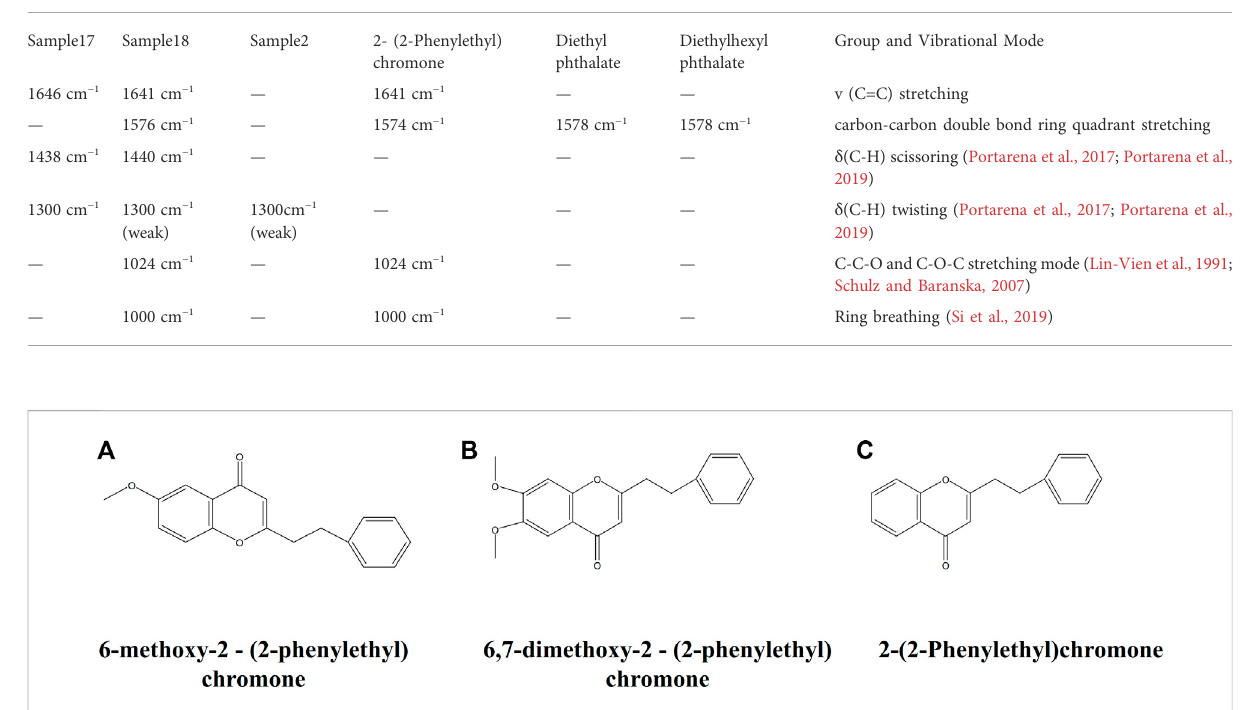
FIGURE 5 Molecular structure of three representative chromone derivatives. (A) 2-(2-Phenylethyl) chromone; (B) 6-methoxy-2 - (2-phenylethyl) chromone; (C) 6,7-dimethoxy-2 - (2-phenylethyl)